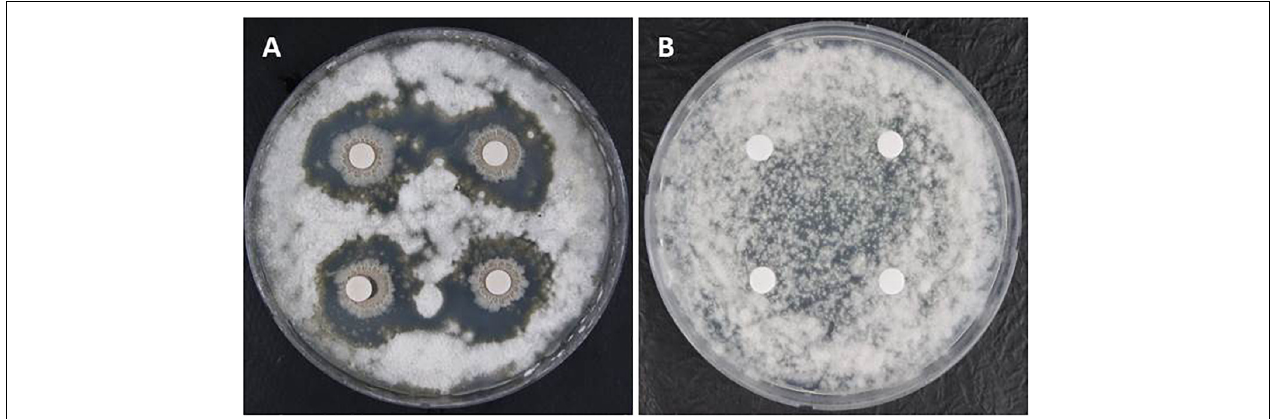
FIGURE 2 | Dual culture plate assay for the in vitro inhibition of Colletotrichum acutatum mycelial growth using an antagonistic bacterium GYUN-300: (A) sterile paper discs loaded with bacterial suspensions (10 8 CFU/mL) placed onto the potato dextrose agar (PDA) plates containing pathogenic fungal spores; and (B) sterile paper discs (6 mm in diameter) loaded with sterilized distilled water (SDW) served as the non-treated control. The inhibition zone was measured 7 days after incubation at 25 ◦ C. The experiment was repeated at least once, with each treatment carried out in triplicates (Petri